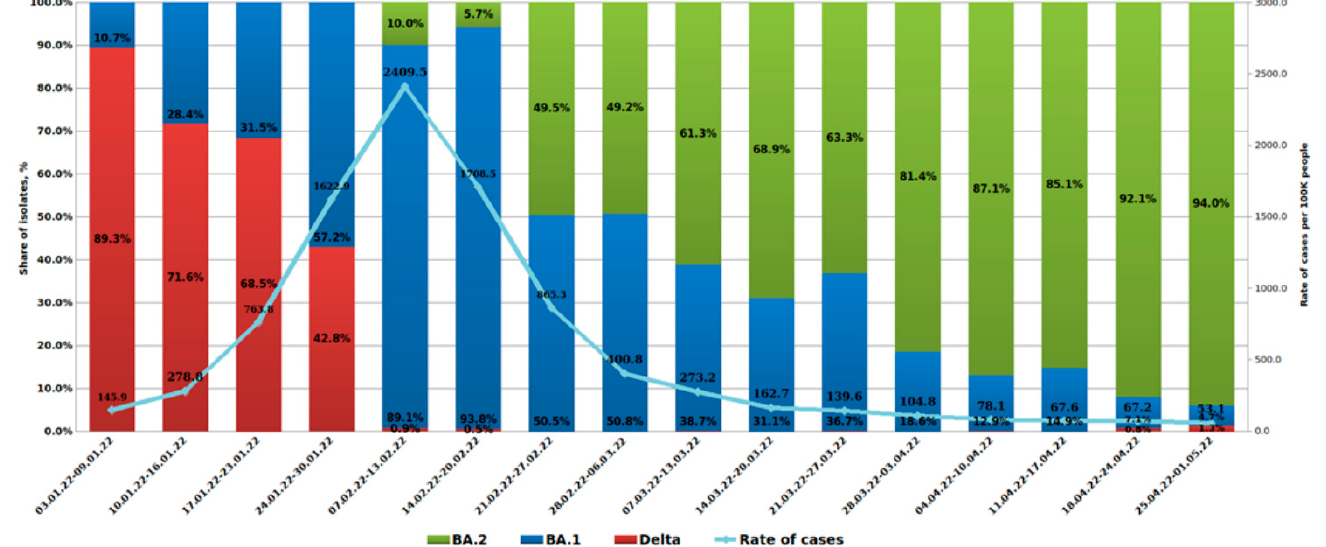
Figure 3. Viral lineage dynamics in hospitalized patients with a confirmed COVID-19 diagnosis. Weekly dynamics of SARS-CoV-2 sublineages in inpatients, and COVID-19 morbidity in St. Petersburg (3 January 2022 to 1 May 2022), are shown.